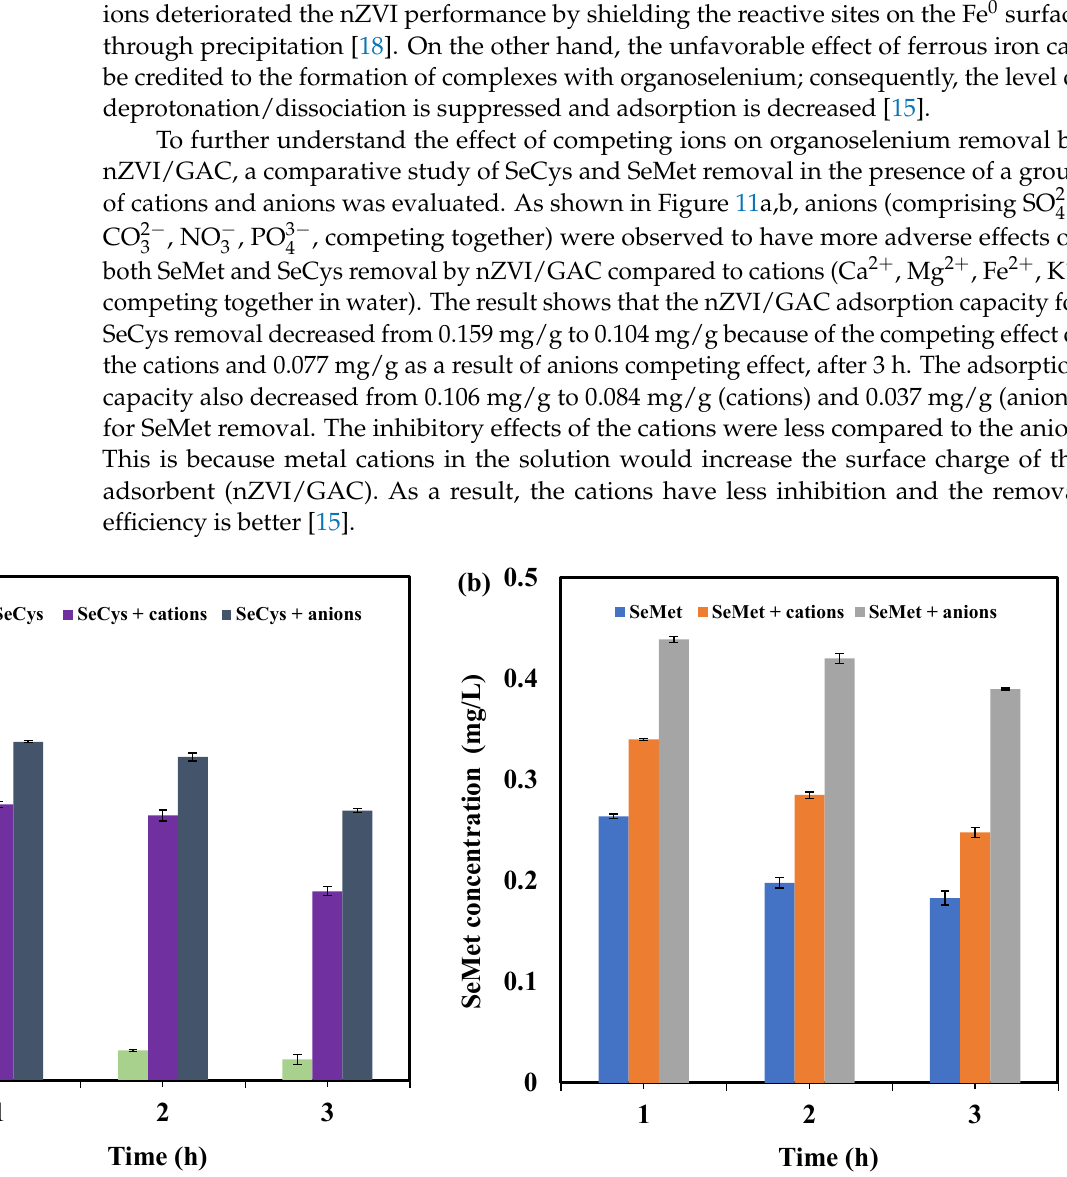
Figure 10. Effects of ions competing individually on organoselenium removal by nZVI/GAC with initial concentration of 0.5 mg/L, 3 g/L, pH 7.0 at 25 °C. The concentration of ions in the solution is 100 mg/L and contact time of 24 h.